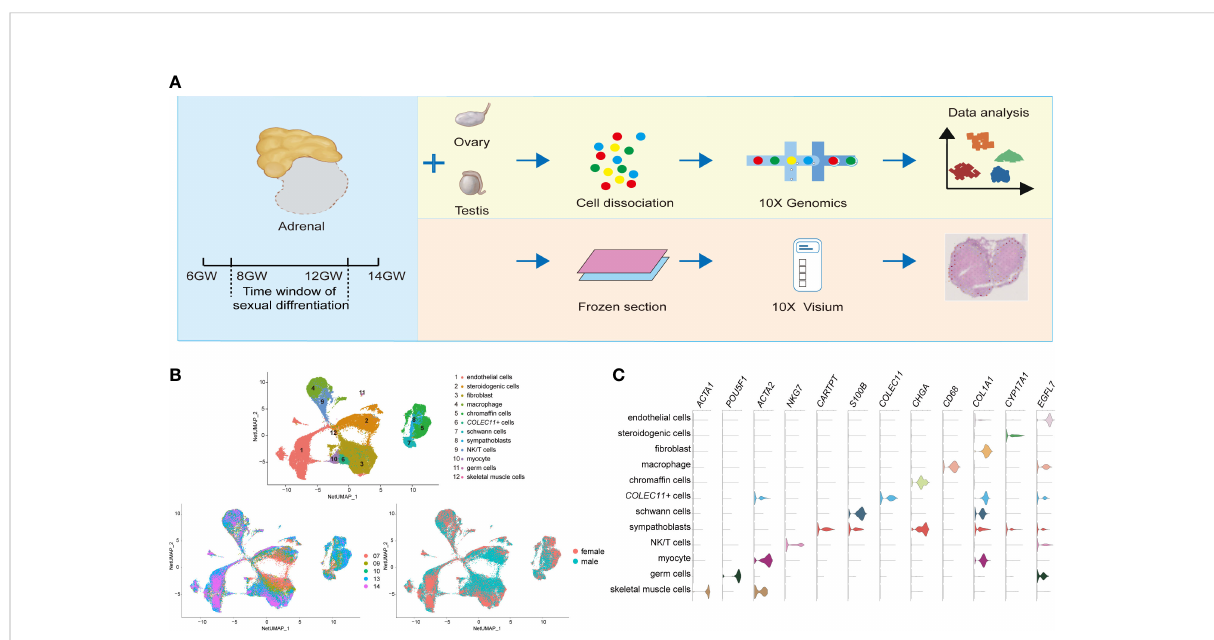
FIGURE 1 Global patterns of single-cell expression pro fi les of fetal adrenal glands. (A) Experimental schematic; 10 adrenal glands and 8 gonads in 10× Genomics; 2 adrenal glands in the Spatial transcriptome. (B) Uniform manifold approximation and projection analysis (UMAP) of the transcriptomes of fetal adrenal cells in 10× Genomics data (n = 75,482). The clusters were identi fi ed by marker genes, as shown in (C) C. Violin plot overview of the expression of selected marker genes by the fetal adrenal clusters. Detailed cell information and differentially expressed genes can be found in Table